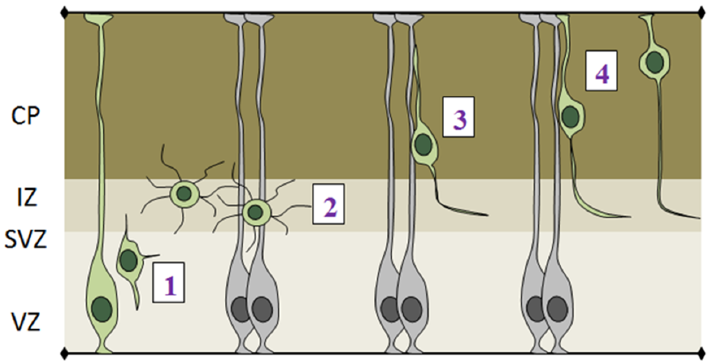
Figure 5. Phases of radial migration of cortical projection neurons. Newborn neurons leave the proliferative areas (1) and reach the intermediate zone where they exhibit a multipolar morphology (2). Neurons exiting the intermediate zone acquire a bipolar morphology and migrate through locomotion using radial glia fibers as scaffold (3). When neurons reach the basal surface they attach the leading process to the pial surface and translocate only the nucleus (4). VZ: ventricular zone; SVZ: subventricular zone; IZ: intermediate zone; CP: cortical plate